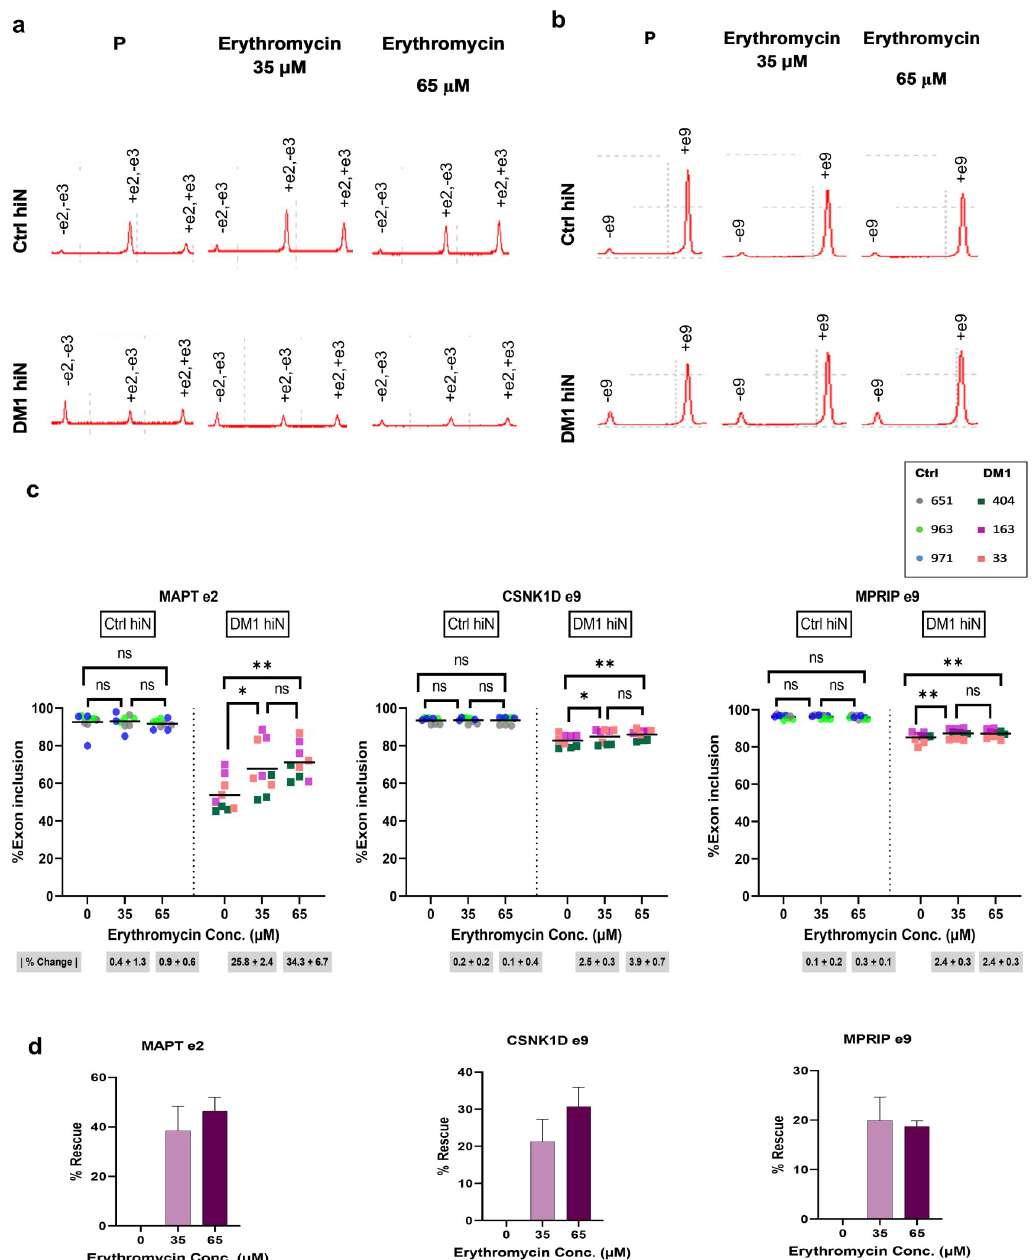
Fig 7. Rescue of MAPT e2, MPRIP e9 and CSNK1D e9 mis-splicing by erythromycin lactobionate treatment at 10 DPI. (a-b) Electropherograms plot the results of RT-PCR products for MAPT e2 (a) and CSNK1D e9 (b) in ctrl (top) and DM1 hiNeurons (bottom). Note the increased inclusion of MAPT e2 (+e2, -e3 and +e2, +e3) and CSNK1D e9 (+e9) in DM1 hiNeurons treated with 35 or 65 μ M erythromycin for 48 h relative to placebo treated DM1 hiNeurons. RT-PCR products were analyzed by MultiNA automated microchip electrophoresis system. (c) Scatter plots show inclusion percentage of MAPT e2 (left), CSNK1D e9 (middle) and MPRIP e9 (right) in control and DM1 hiNeurons treated with placebo or erythromycin. n = 3 for each group. Each sample is presented in different color. Each symbol represents percentage of exon inclusion for one sample replicate. Line represents mean. � P < 0.05, �� < 0.01 and ns, not significant compared by repeated measures one-way ANOVA test. Erythromycin treatment had no adverse effects on control group. Absolute values of mean change percentage |% change| ± SEM relative to placebo treated cells in each group are indicated below the graphs. (d) Bar graphs show rescue percentage of aberrant splicing of MAPT e2 (left), CSNK1D e9 (middle) and MPRIP e9 (right) in DM1 hiNeurons by erythromycin treatment. Note that erythromycin rescued MAPT exon 2 mis-splicing by 38.4% or 46.4% at a concentration of 35 or 65 μ M, respectively. Data are presented as mean ± SEM. P, placebo (same amount of diluent without